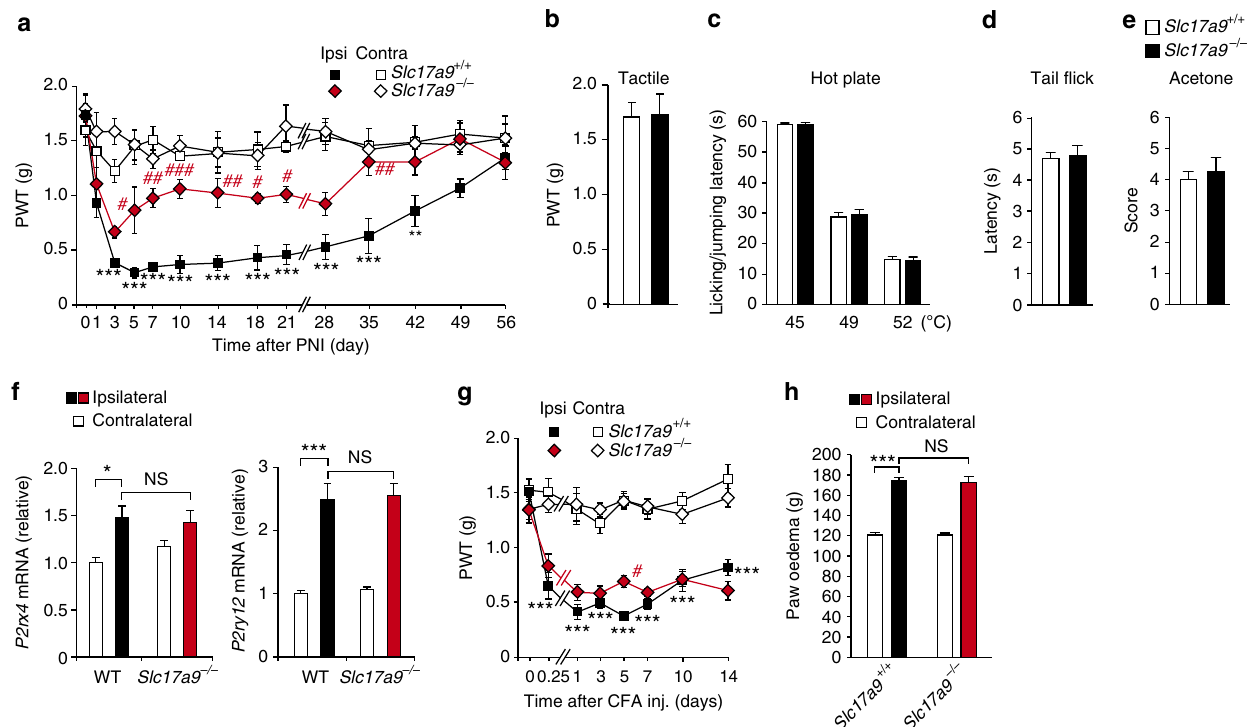
Figure 2 | VNUT deficiency attenuates PNI-induced pain hypersensitivity without affecting acute pain sensation or inflammatory pain. ( a ) Paw withdrawal threshold (PWT) to tactile stimuli of Slc17a9 (cid:2) / (cid:2) mice and WT littermates ( Slc17a9 þ / þ ) before and after PNI ( n ¼ 5; *** P o 0.001 versus the contralateral side of Slc17a9 þ / þ mice; # P o 0.05, ## P o 0.01, ### P o 0.001 versus the ipsilateral side of Slc17a9 þ / þ mice, two-way ANOVA with post hoc Bonferroni test). ( b ) PWTof Slc17a9 (cid:2) / (cid:2) and Slc17a9 þ / þ mice under normal conditions ( n ¼ 5). ( c ) Hot-plate test, where values represent the latencies for animals to lick their hindpaws or jump ( n ¼ 8). ( d ) Tail-flick test, where values represent the latencies to flick their tail from the heat source ( n ¼ 8). ( e ) Acetone test, where values represent the pain scores after acetone application ( n ¼ 8). ( f ) Real-time PCR analysis of mRNAs of P2rx4 and P2ry12 in the spinal cords of WT and Slc17a9 (cid:2) / (cid:2) mice 7 days after PNI. Values represent the relative ratio of mRNA (normalized to the value for 18S mRNA) to the contralateral side of WTmice ( n ¼ 6; * P o 0.05, *** P o 0.001, one-way ANOVA with post hoc Tukey Multiple Comparison test). ( g ) PWTof Slc17a9 (cid:2) / (cid:2) and Slc17a9 þ / þ mice before and after intraplantar CFA injection ( n ¼ 6; *** P o 0.001 versus the contralateral side of Slc17a9 þ / þ mice; # P o 0.05 versus the ipsilateral side of Slc17a9 þ / þ mice, two-way ANOVA with post hoc Bonferroni test). ( h ) Paw size, as a measure of edema, in Slc17a9 (cid:2) / (cid:2) and Slc17a9 þ / þ mice 7 days after intraplantar CFA injection ( n ¼ 6; *** P o 0.001, one-way ANOVA with post hoc Tukey Multiple Comparison test). Values are means ± s.e.m. NS, not (siRNA-1) significantly suppressed the expression of spinal behaviour were obtained using an additional VNUT siRNA Slc17a9 mRNA and ameliorated PNI-induced allodynic beha- (siRNA-2) (Fig. 3c,d). Moreover, these siRNA treatments carried viour (Fig. 3c,d). Similar effects on gene expression and pain out during the maintenance phase also reversed established